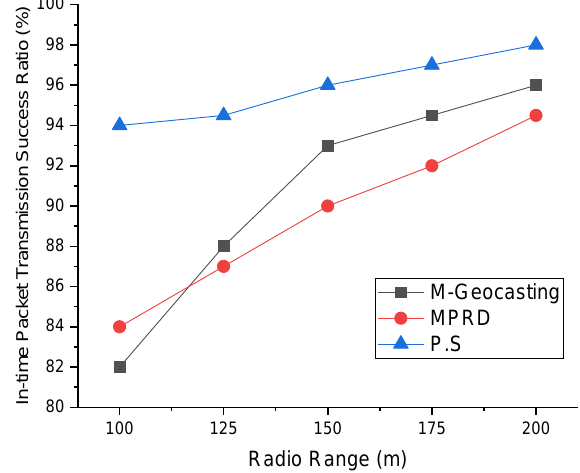
Figure 9. Comparison of in-time packet transmission success ratio according to the number of workers.